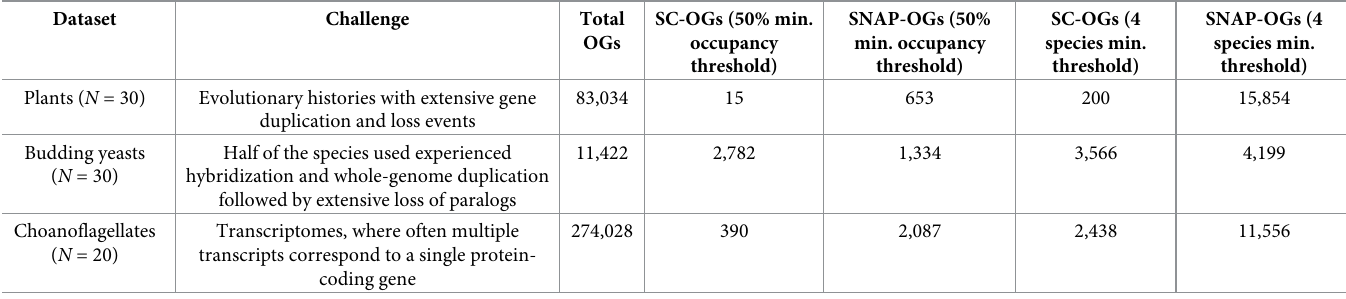
Table 2. OrthoSNAP identifies SNAP-OGs in complex